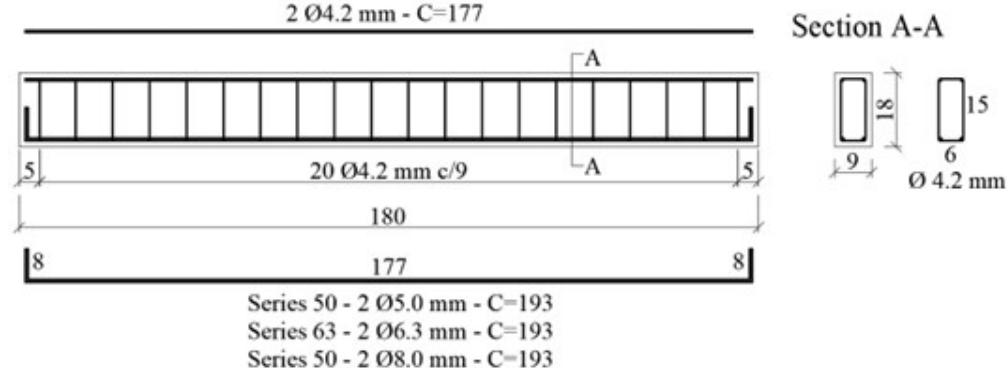
Figure 1. Schematics of original undamaged specimens. Dimensions in centimeters unless otherwise